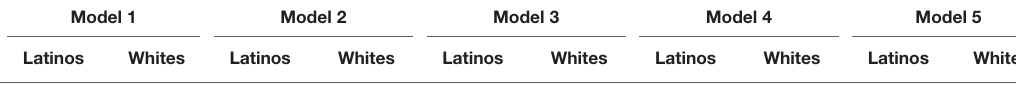
TABLE 1 | Predictors of odds of having contacted a government official in the past 12